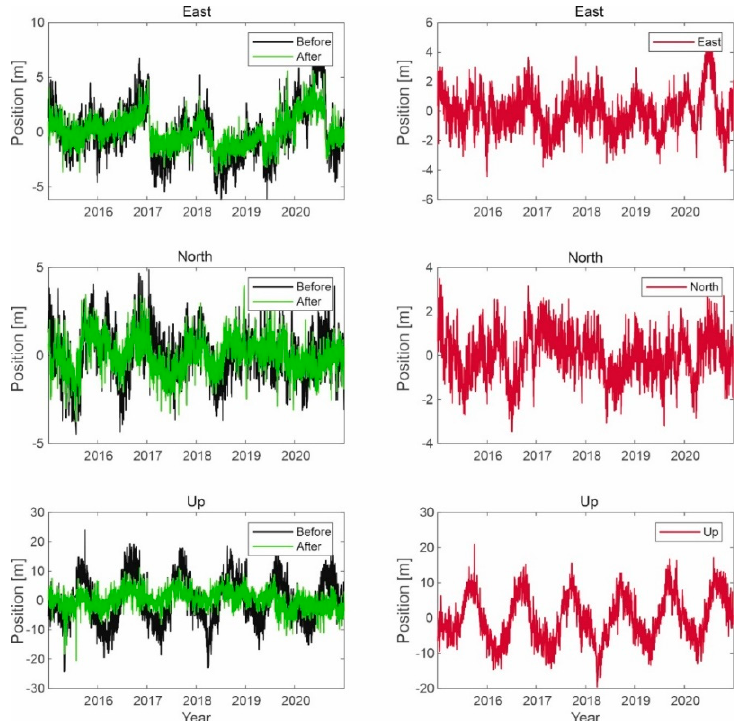
Figure 15. Signal processing in the Galileo receiver operating on the L1 frequency; on the left side, the signal waveform in color without the noise suppression system applied; on the right side, the working system operating in the LTE system signal elimination for the reception of signals from six satellites.